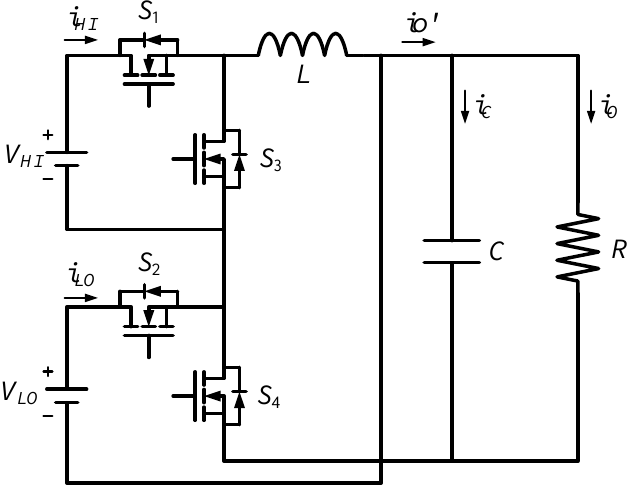
Figure 2. The circuit diagram of the multi-input step-up/step-down converter.